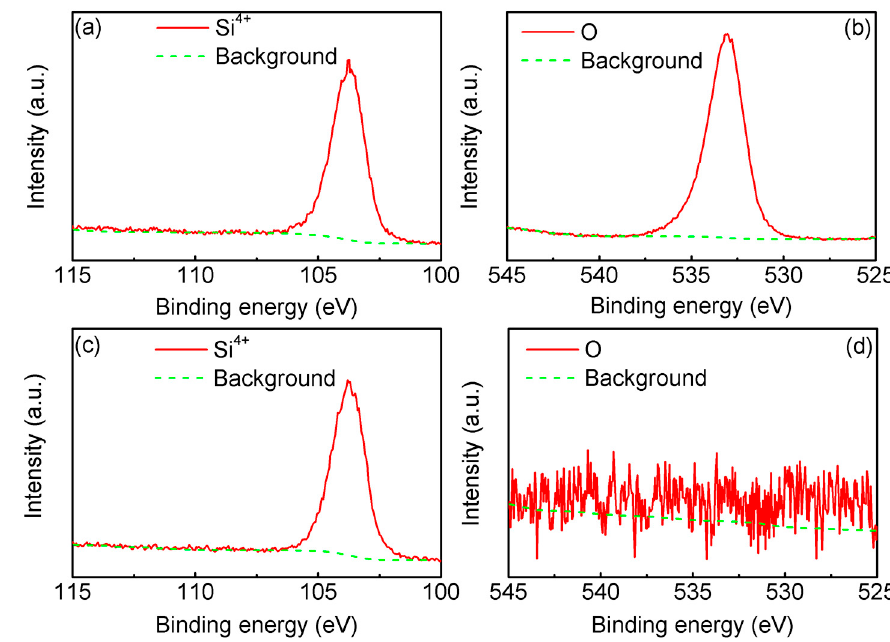
Figure 2. X-ray photoelectron spectroscopy (XPS) data of Si 2p and O 1s electrons for the single-crystalline silicon plates after thermal oxidation (3 min) before etching using the Ar ion process ( a ), ( b ) and after etching using the Ar ion process ( c , d ). ( a , c ) and ( b , d ) are the surface XPS data of Si 2p and O 1s, respectively.